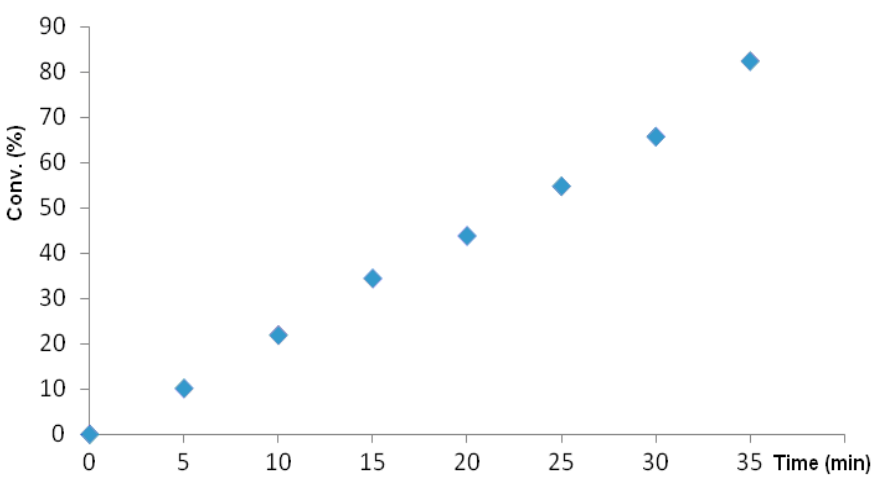
2. Evolution conversion as a function of polymerization time (min).